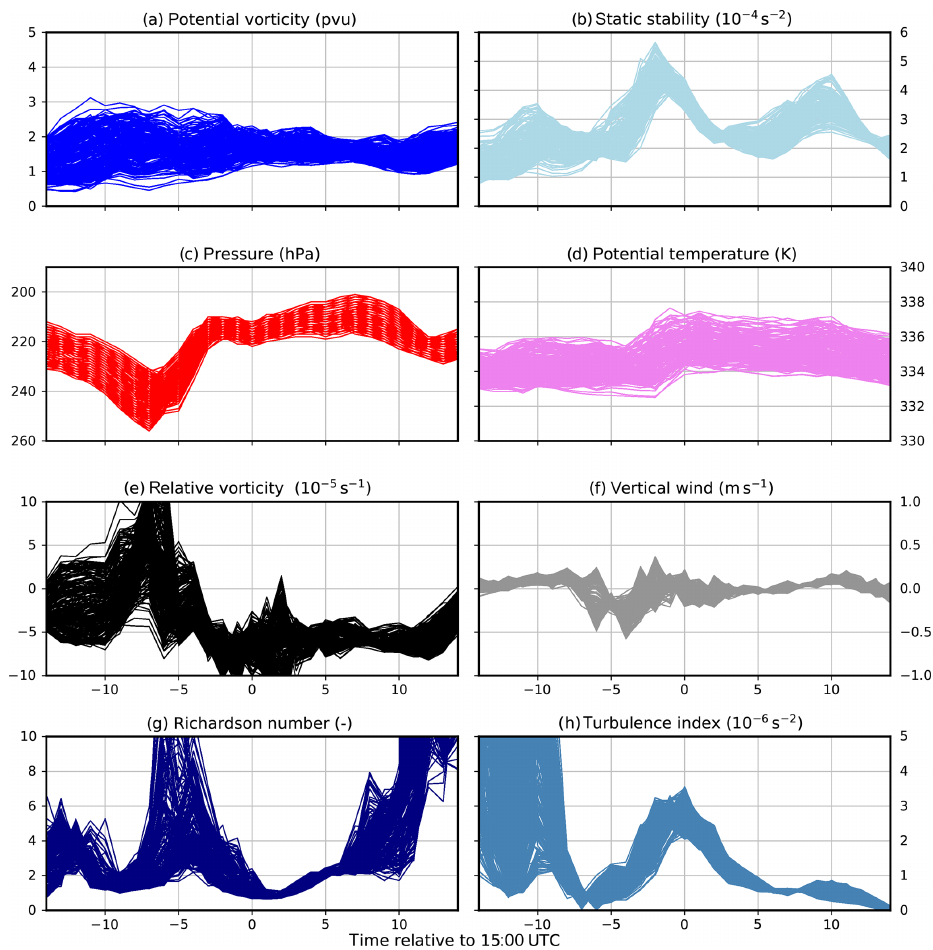
Figure 8. Time series of dynamic and thermodynamic quantities of mixing trajectories crossing the dynamic tropopause and experiencing a KHI. The time axis is relative to 28 September 2017 at 15:00UTC. The eight panels show the following variables along the trajectories: (a) potential vorticity (in pvu), (b) static stability (in 10 − 4 s − 2 ), (c) pressure (in hPa), (d) potential temperature (in K), (e) relative vorticity (in 10 − 5 s − 1 ), (f) vertical wind (in ms − 1 ), (g) Richardson number, and (h) turbulence index after Ellrod et al. (1992) (in 10 − 6 s − 1 ). Note that the time period shown here is shorter than the total time period used for the trajectory